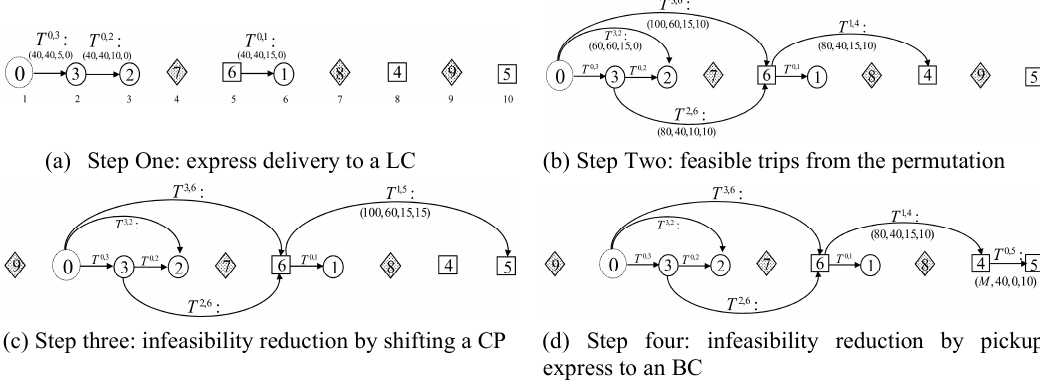
Fig. 5. Construction of the auxiliary